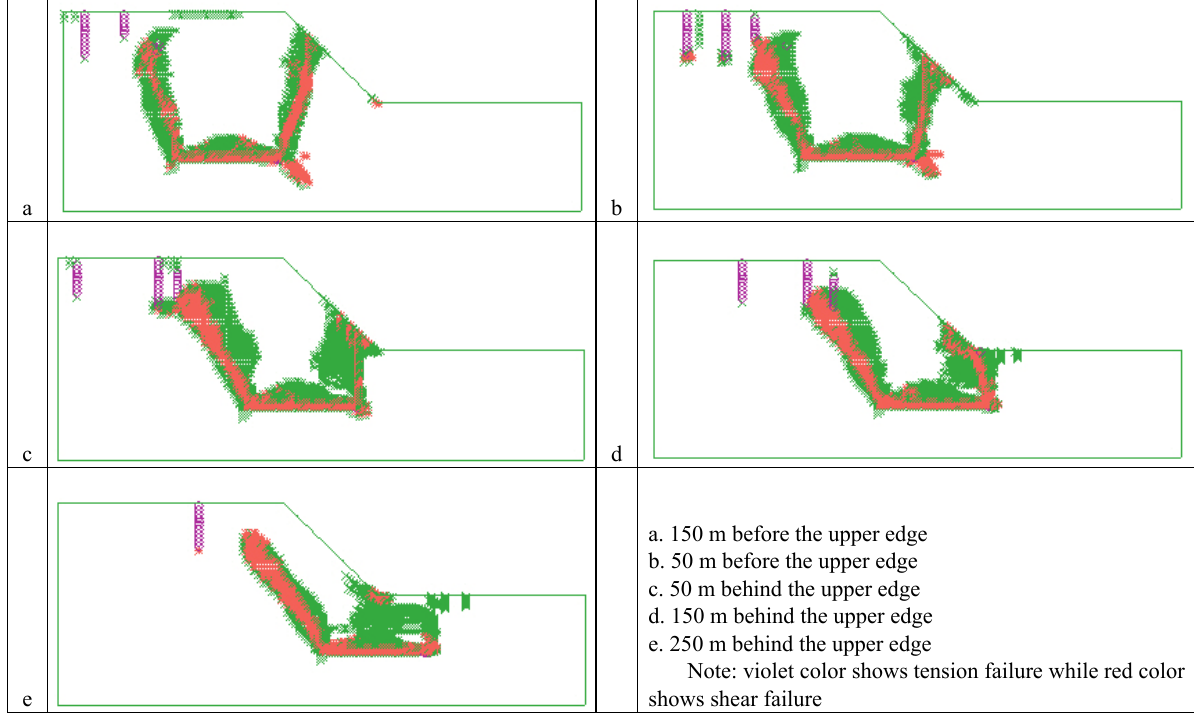
Fig. 13. Plasticity indicator of rock mass at different positions of longwall panel (measured point is the center of the longwall